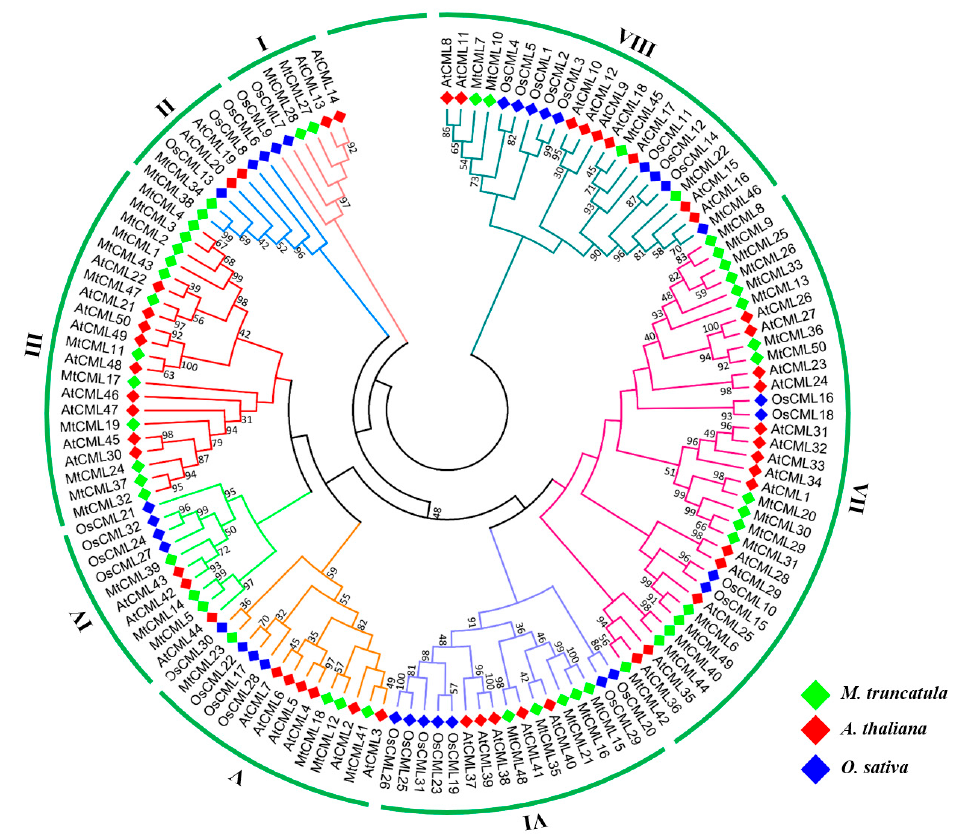
Figure 1. Phylogenetic tree of calmodulin-like (CML) proteins in Medicago truncatula , Arabidopsis thaliana and Oryza sativa. Tree constructed with 1000 bootstrap replications. CMLs from M. truncatula , A. thaliana and O. sativa distinguished using green, red and blue color, respectively.